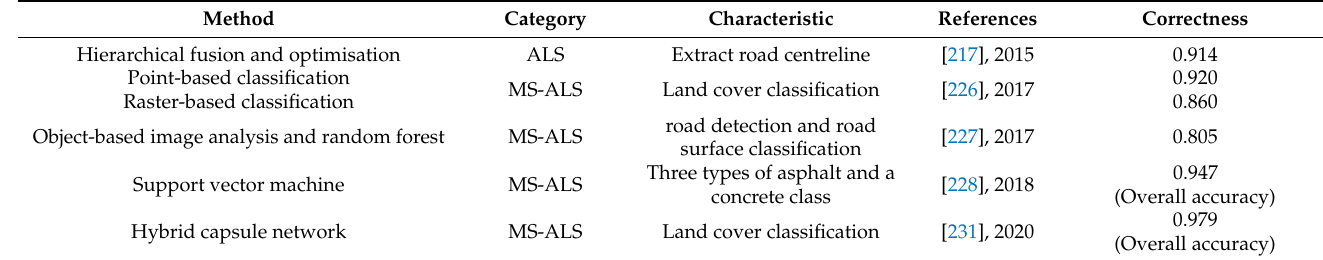
Table 7. Summary of road extraction using LiDAR